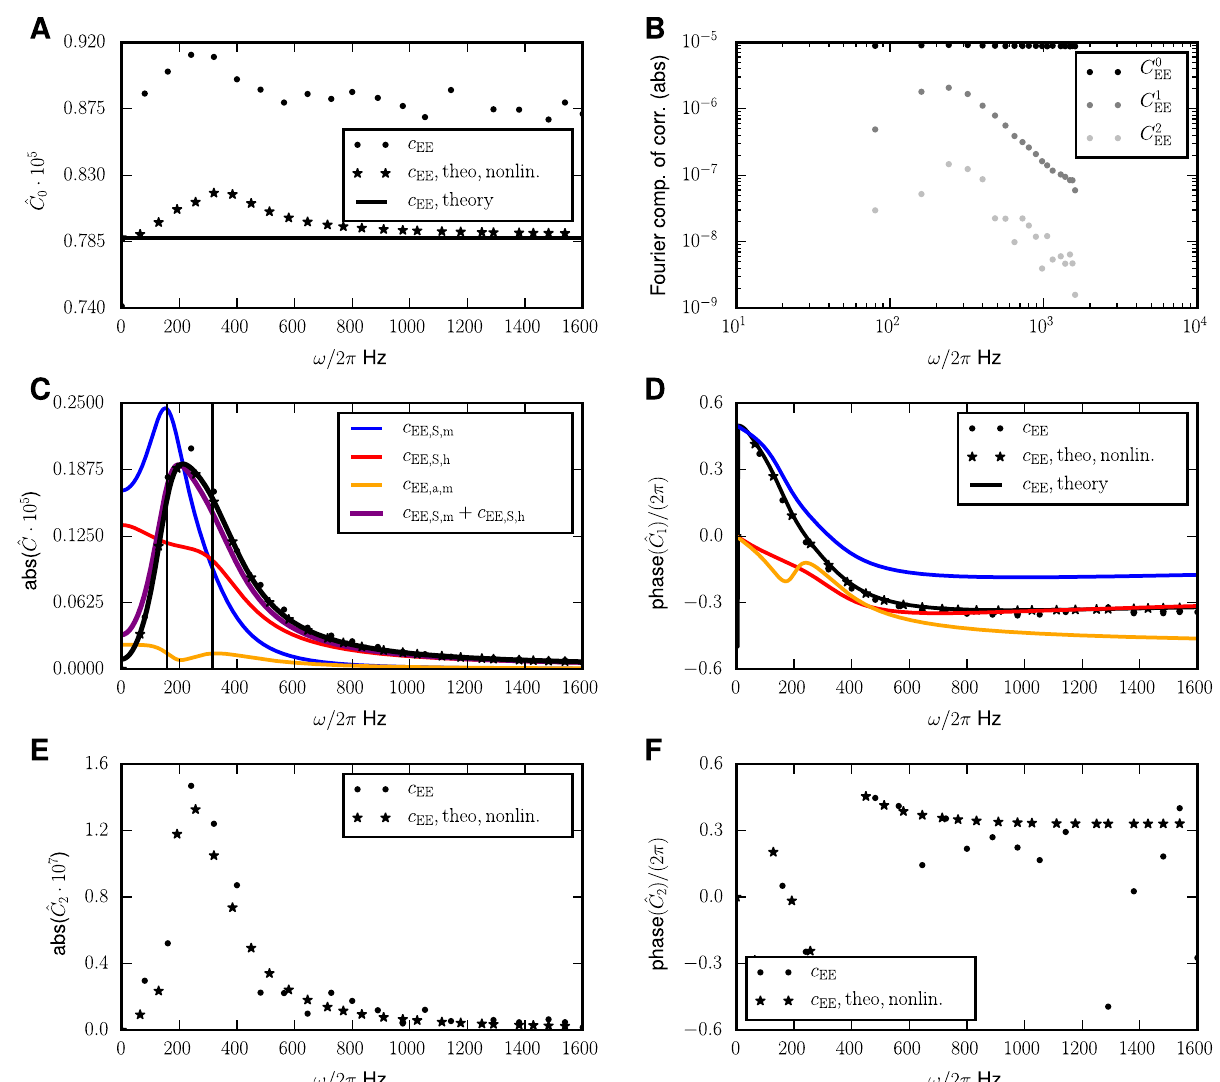
Fig 6. Driven E-I network with biologically inspired parameters: EE-Covariance. Responseof the covariance to a perturbationwith frequency ω in the Fourier space. A Zeroth Fourier mode (time independentpart) of the covariance. B Absolut value of the first three Fourier components of the c ee -covariances on a loglog-scale. C Absolute value of the first order of the time-dependent part of the covariance. D Phase angle in relationto the driving signal. E and F are analogousto C and D for the second Fourier modes. Solid lines indicate the linear theory Eq (39), stars the results of the numerical solutionof the full mean-fieldtheory Eqs (5) and (6) and dots the direct simulationof the full network. Numerical results obtained by the same methods as in Fig 3. Parametersof the network model as in Fig 5.